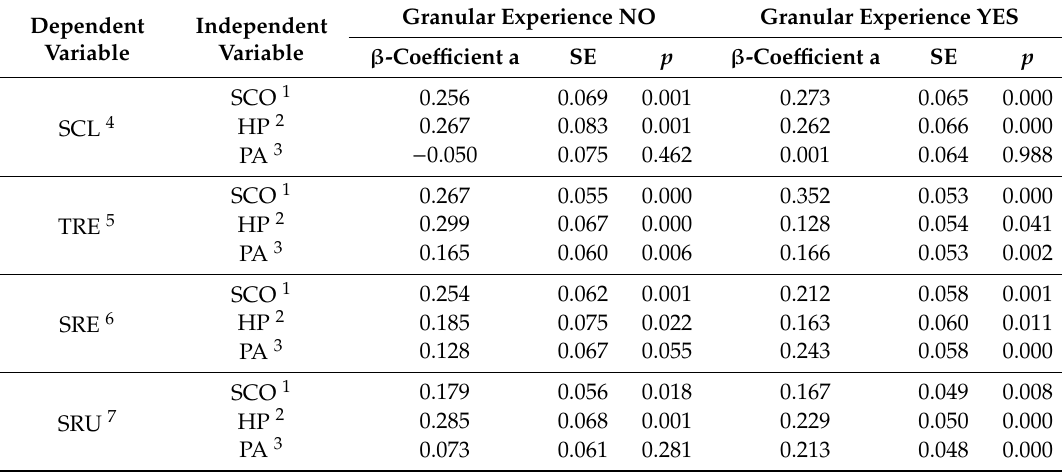
Table 7. Linear Regression of Physical Self-Concept and School Adjustment According to Award (n = 589).